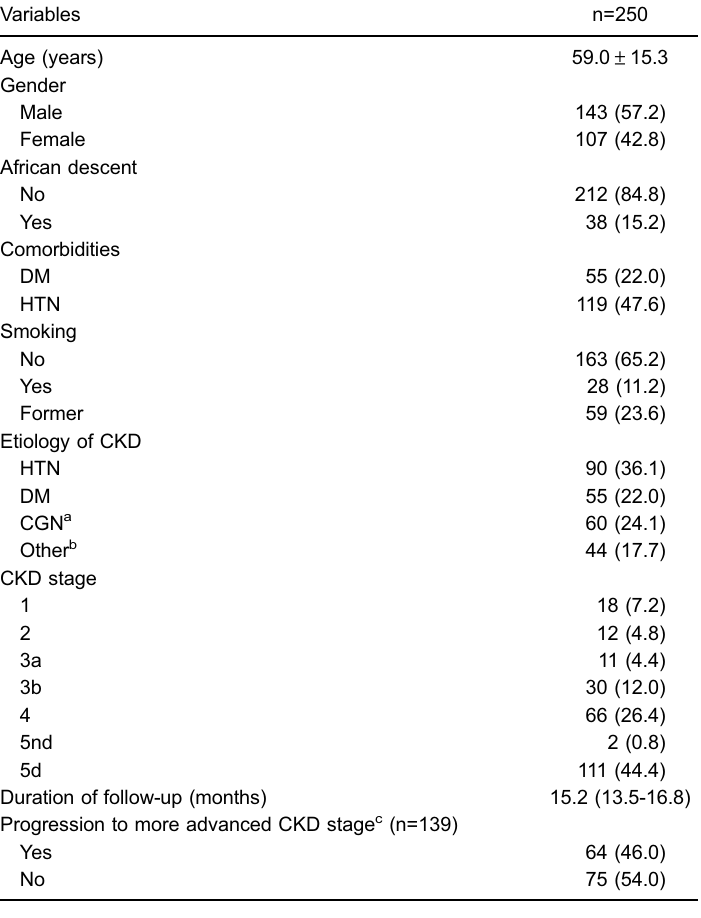
Table 1. Baseline characteristics of participants with chronic kidney disease stages 1 to 5, including